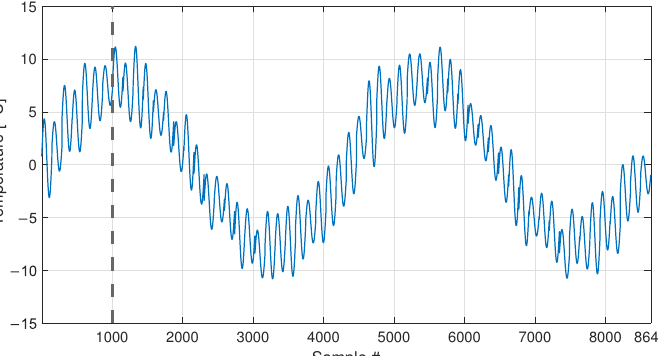
Figure 9. Simulated temperature trend: long-term and short-term trends. The vertical dashed line identifies the number of samples used as baseline in sim 3.